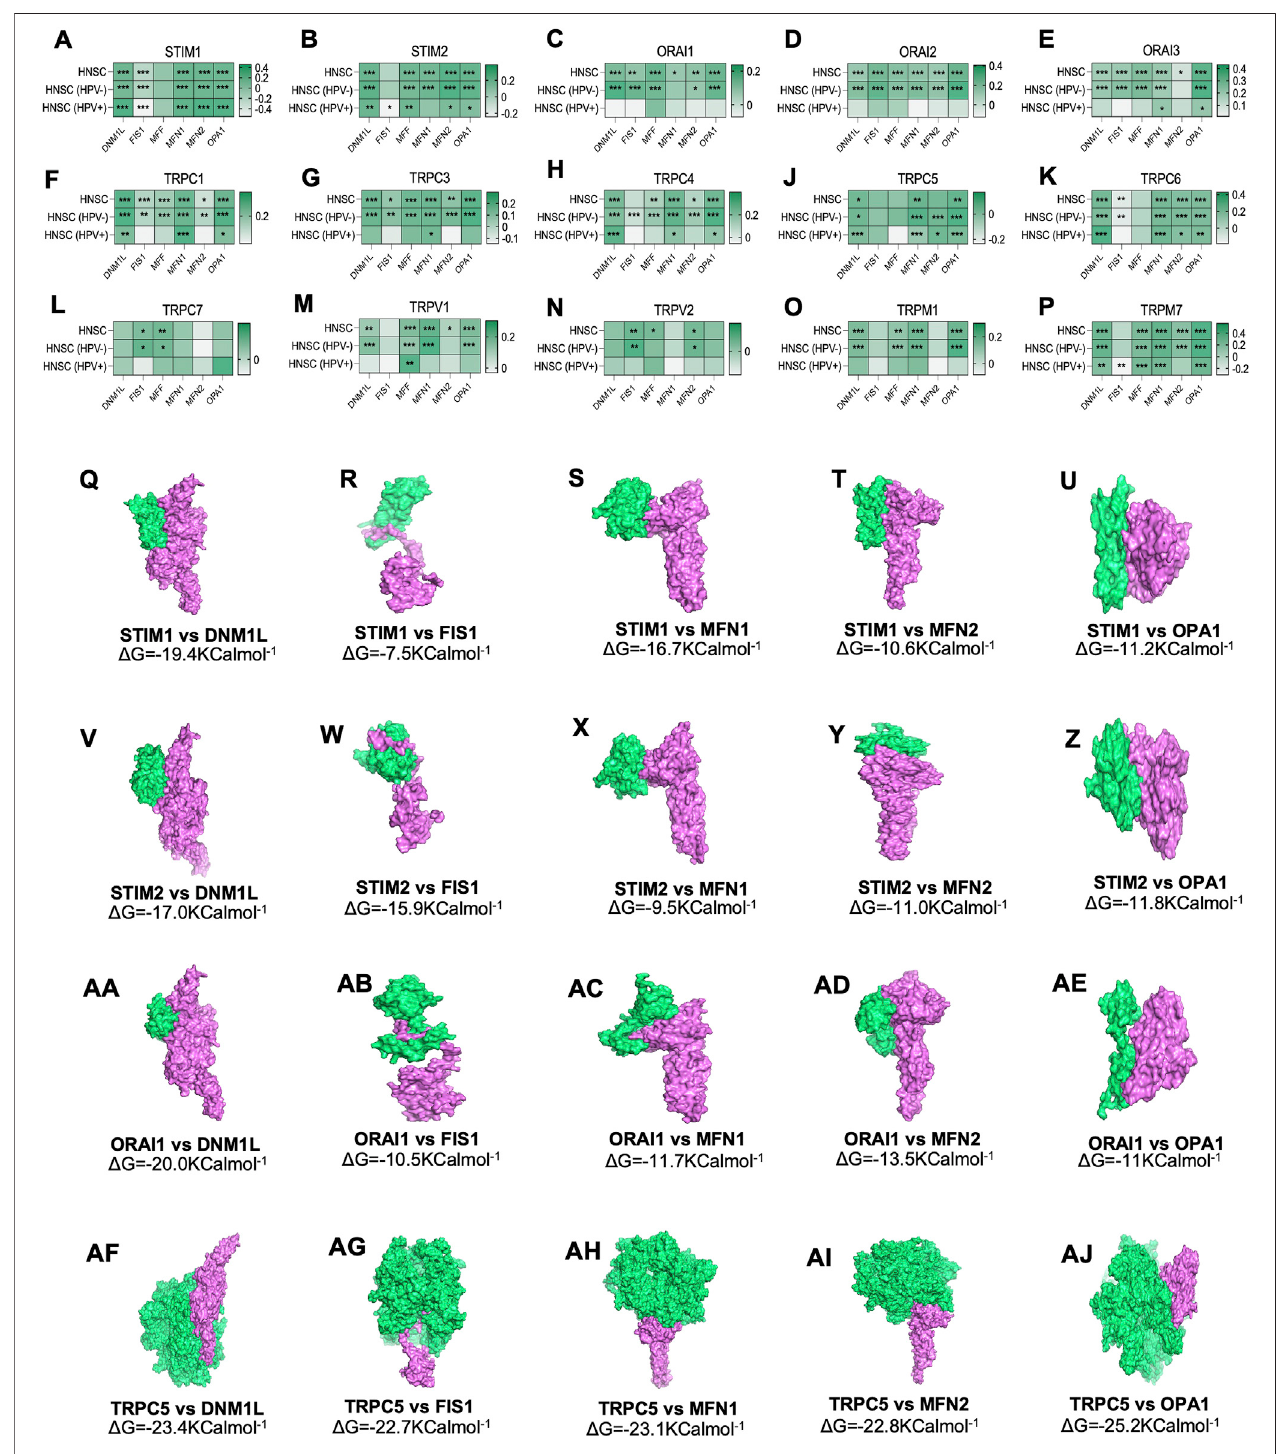
FIGURE 4 | Altered mRNA expression of SOCs are correlated with the expression of MDGs in HNSC. (A – P) The Hiseq2 gene expression TCGA-HNSC data was downloaded. The expression levels of SOCs are compared with the expression of MDGs using Timer 2.0 tool. The statistical signi fi cance is represented in asterisk. * p < 0.05, ** < 0.01, *** p < 0.001. (Q – AJ) Protein structures for SOCs- STIM1 (PDB ID-6YEL), STIM2 (PDB ID-2L5Y), ORAI1 (PDB ID-4EHQ), TRPC5 (PDB ID-6YSN)- and MDGs-DNM1L(PDBID-3W6N),MFN1(PDBID-5GOF),MFN2(PDBID-6JFK),OPA1(PDBID-6JTG)andFIS1(PDBID-1PC2)weredownloadedinthe.pdbformat from protein data bank and docked using ClustPro tool. The protein in green represents SOCs and pink represents MDGs. Prodigy was used to calculate Δ G.